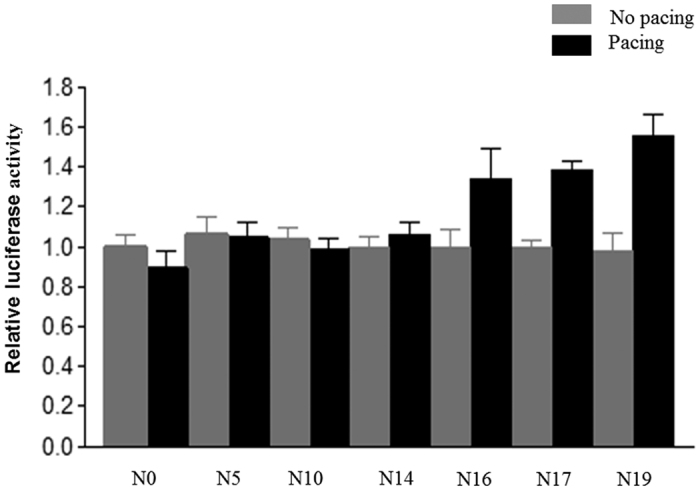
CCTTT repeats modulated the transcriptional activity of the iNOS gene and its responsiveness to rapid pacing.Luciferase activity was assayed as described in the Methods section. HL-1 cells were transfected with plasmids containing various lengths of CCTTT repeats (N) in the iNOS promoter for 24 hours with/without subsequent tachypacing (4 Hz) for 2 hours. Each value (mean ± SE, at least three independent experiments) is expressed as a fold change in luciferase activity relative to the control (N = 0) condition. Two-way ANOVA reported a significant effect of various lengths of CCTTT repeats (P = 0.005), of pacing (P = 0.001), and of the interaction between the main effects (P = 0.001).